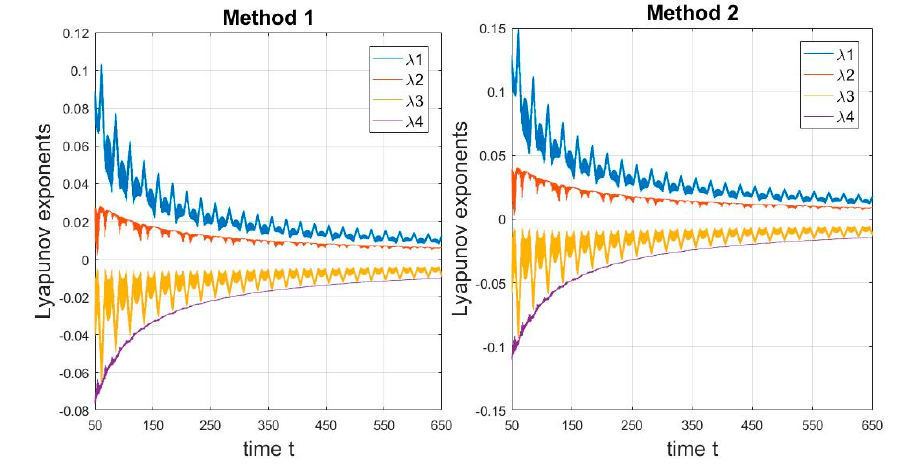
Figure 4. Phase planes (gray lines) and Poincar é maps (red and green dots) for ω = 7.24.